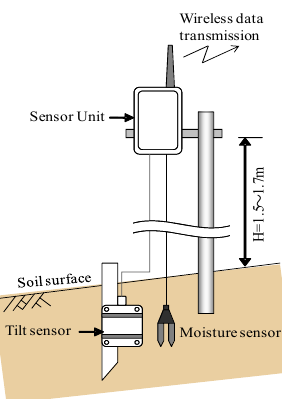
Figure 1. Wireless sensor unit with tilt and water content sensors on a slope, rain gauge and tensiometer are also compatible with the sensor unit as an alternative.